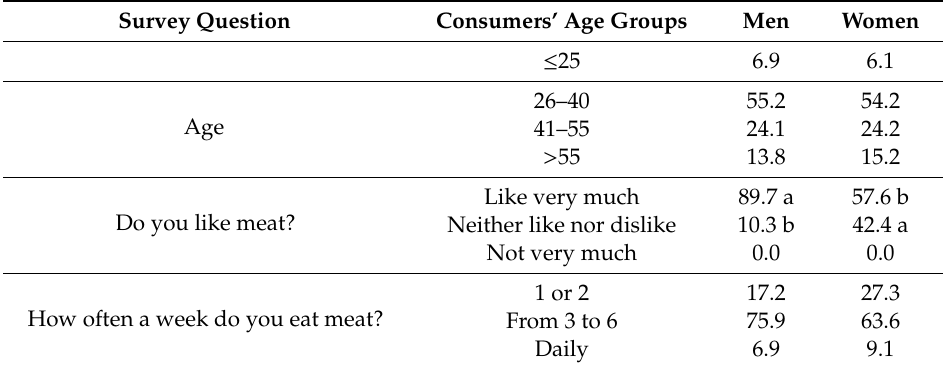
Table 7. Consumers’ profile for the home test. Percentages of valid